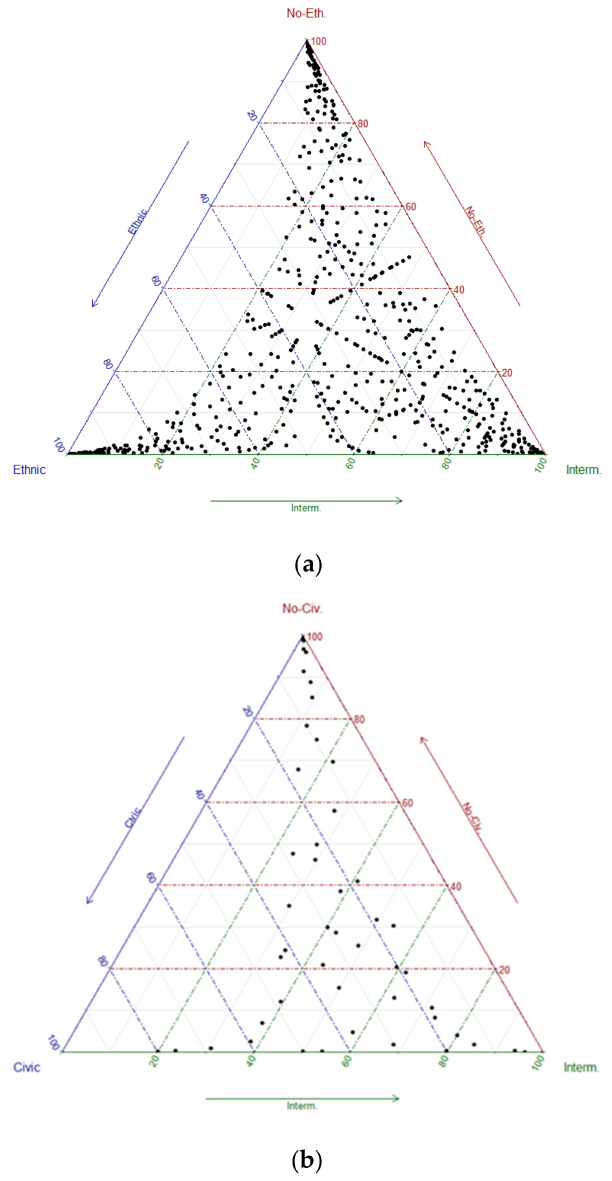
Figure 1. Fuzzy clustering ternary graphs; ( a ) Ethnic National Identity; ( b ) Civic National